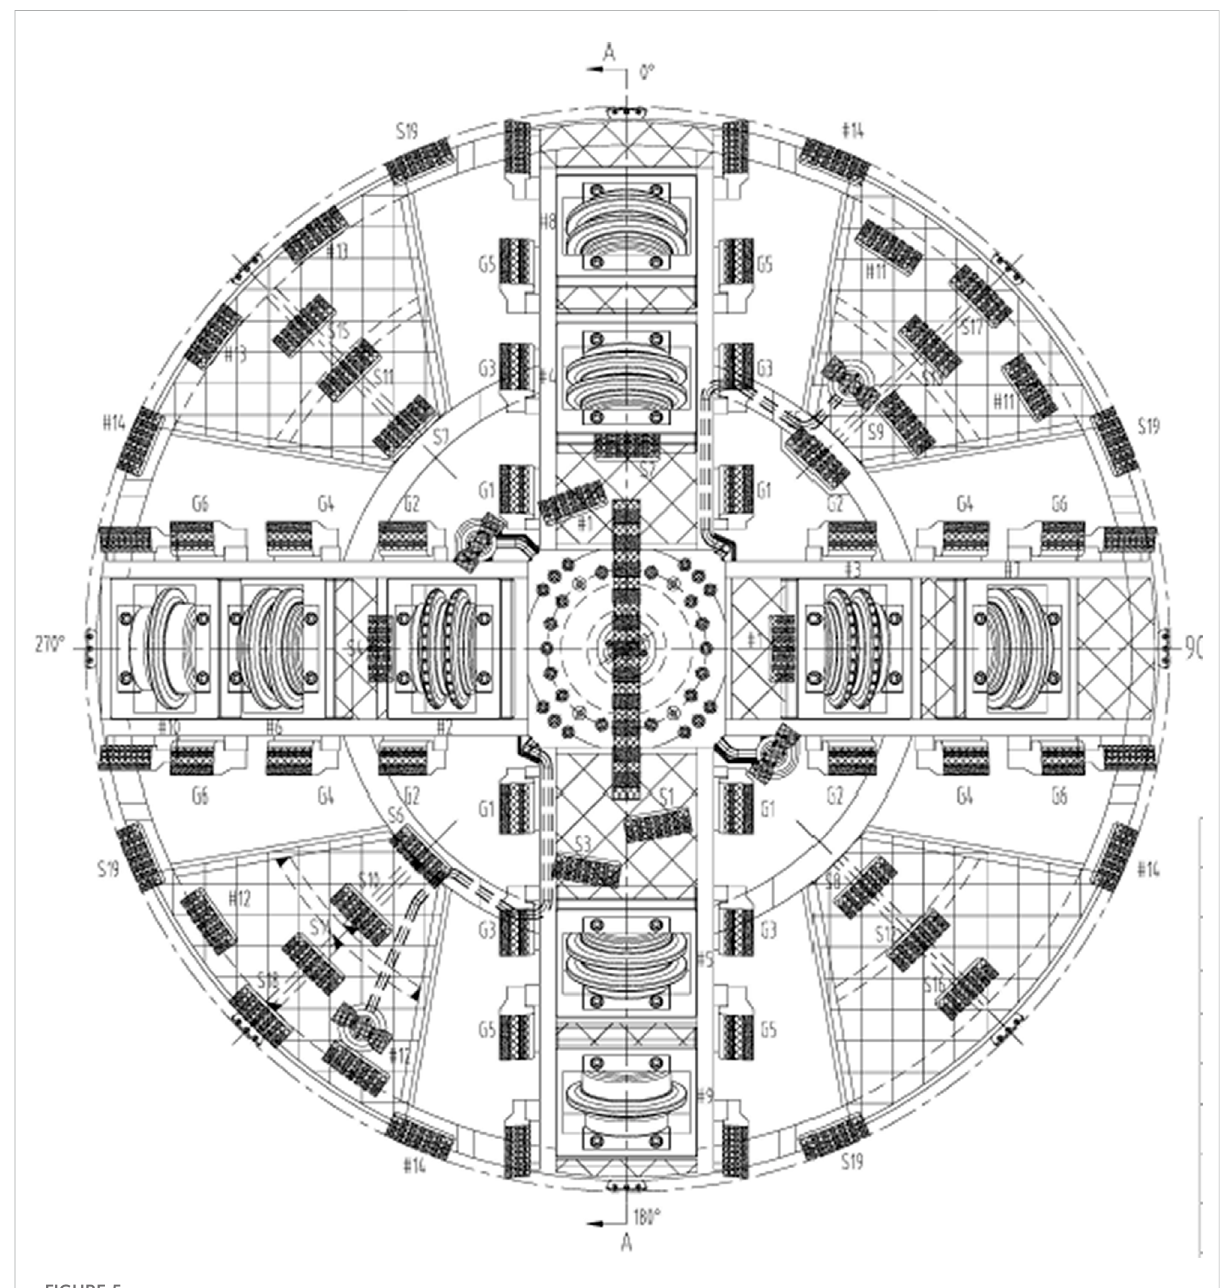
FIGURE 5 Cutter